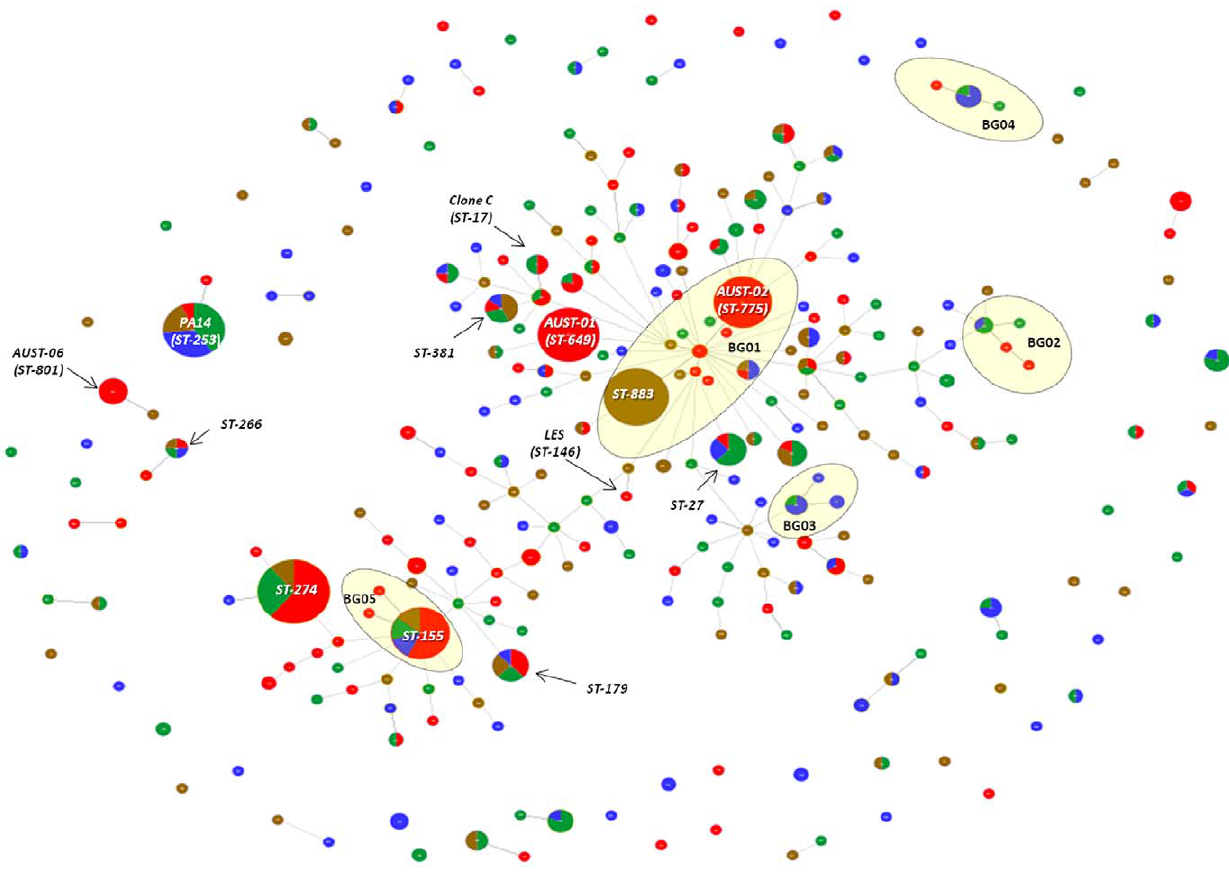
Figure 4. goeBURST Minimal Spanning Tree of the 499 typeable Pseudomonasaeruginosa isolates (n=272 sequence types). All sequence types (STs) were grouped up to the triple-locus variant level. Each circle corresponds to an individual ST and the dimensions of each circle are relative to the number of isolates belonging to that ST. Red, green, brown and blue circles represent isolates collected from patients with cystic fibrosis (CF), non-CF patients, animals and environmental samples, respectively. Whenever isolates of the same ST have a different ecological source, the number of isolates derived from the same source is proportional to the respective colour. Yellow coloured zones (labelled BG01 to BG05) represent the five predominant BURST groups that each consisted of three or more